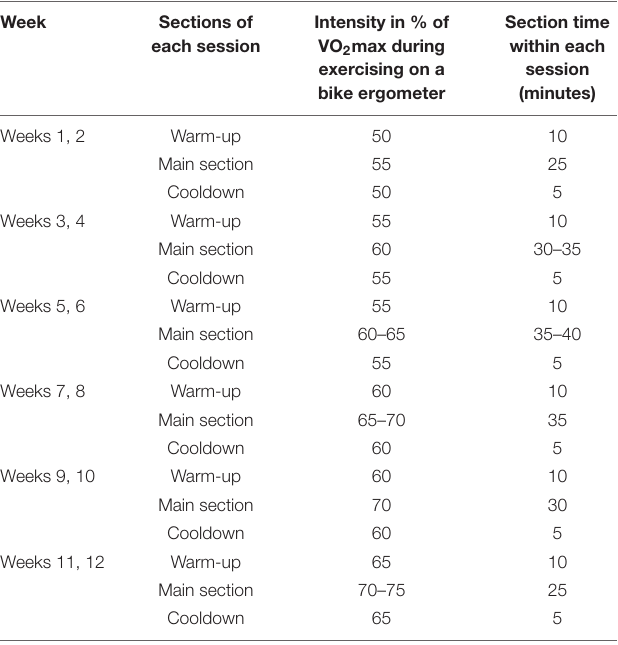
TABLE 1 | Progression of intensity and session duration of the endurance-dominated exercise program in combination with gait therapy across the 12 weeks intervention